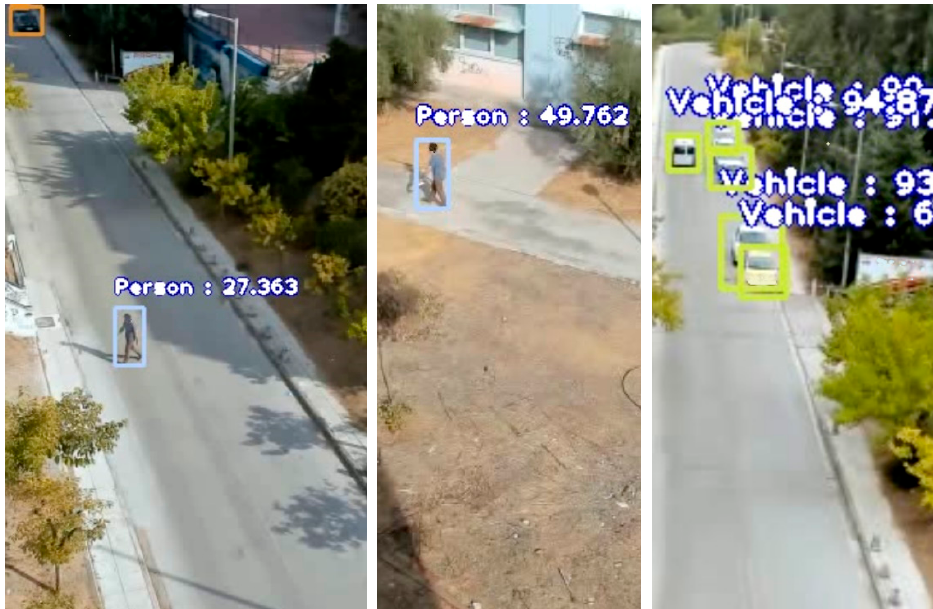
Figure 14. Object detection results (persons in cyan and car in orange/yellow rectangles) applying the custom YOLOv3 model in real case videos.